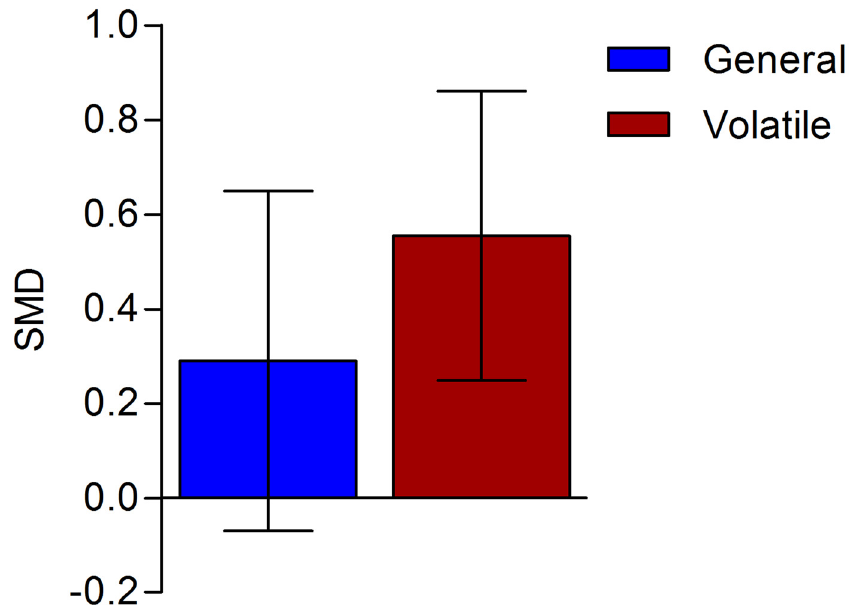
Fig 4. The impact of volatile anaesthetics. The columns depict the effect estimate (SMD) with the 95% confidence interval. The results from subgroup analyses (volatile anaesthetics) were only interpreted when subgroups contained at least 3 studies or 5 independent